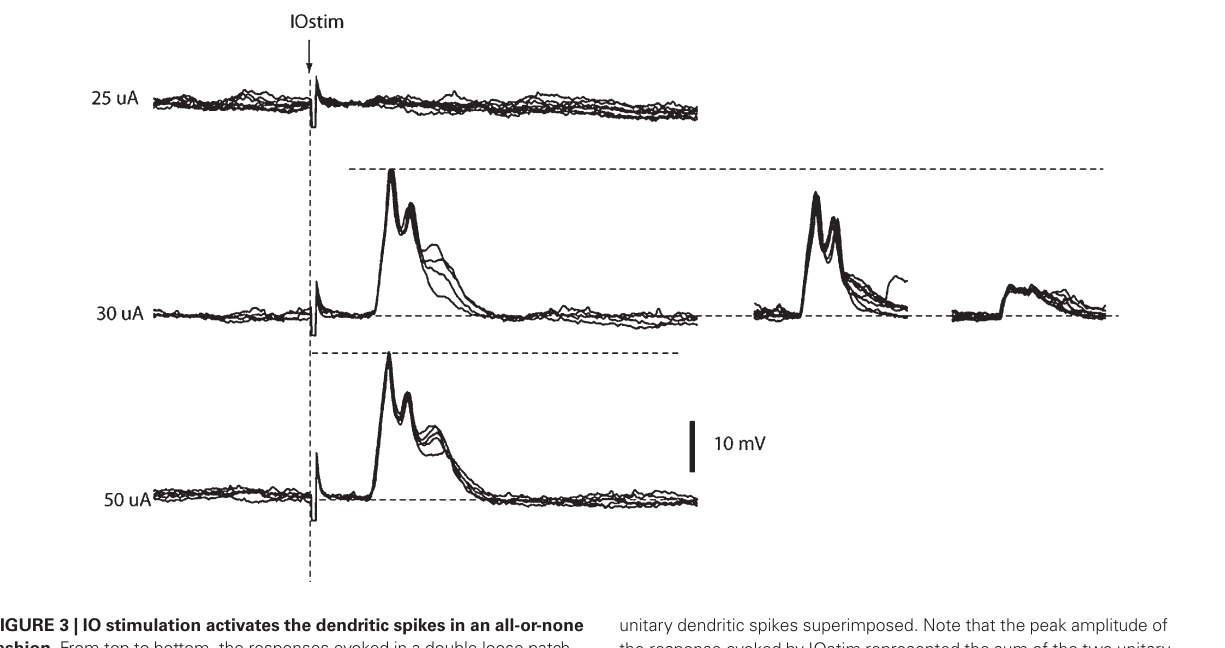
unitary dendritic spikes superimposed. Note that the peak amplitude of the response evoked by IOstim represented the sum of the two unitary dendritic spikes, showing that both dendritic spikes were activated by the